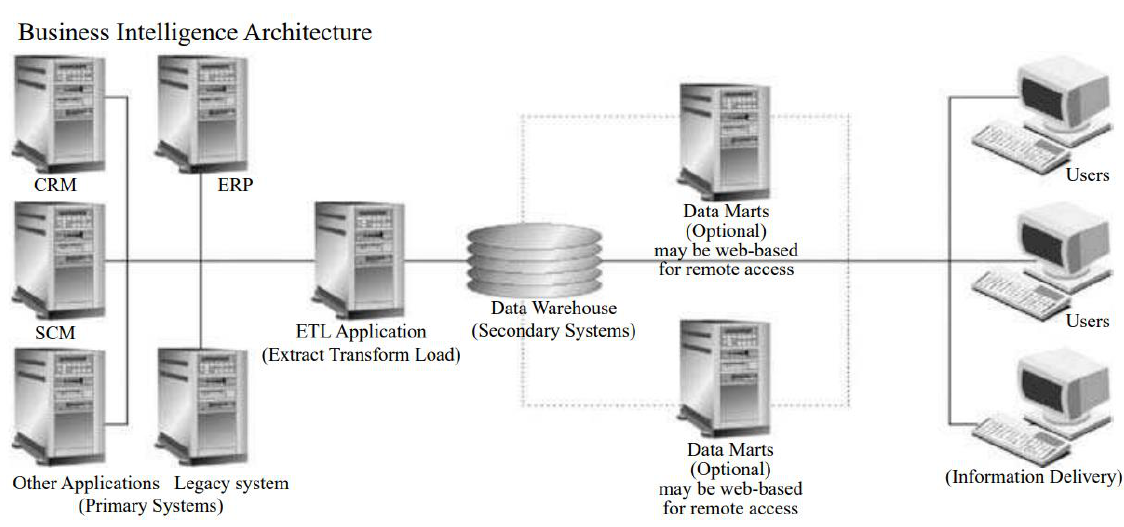
Figure 2: The architecture of BI (Source: Schulte, 2005) Sazu et al. (2022) proposed an approach to real time BI dependent on service oriented architecture [19]. As businesses seek to integrate intelligence into business operations, a strong infrastructure is essential to meet mission critical demands for high scalability, accessibility, and results. Sazu et al. proposed a genuine period BI structure for an adaptive enterprise